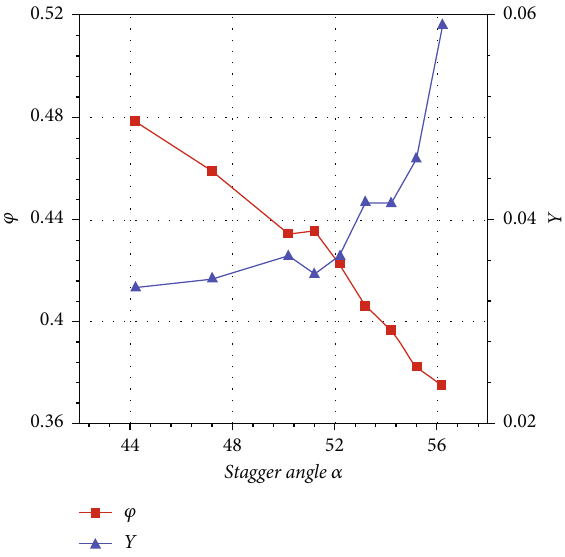
Figure 6: Flow coe ffi cient and total pressure loss coe ffi cient for di ff erent stagger